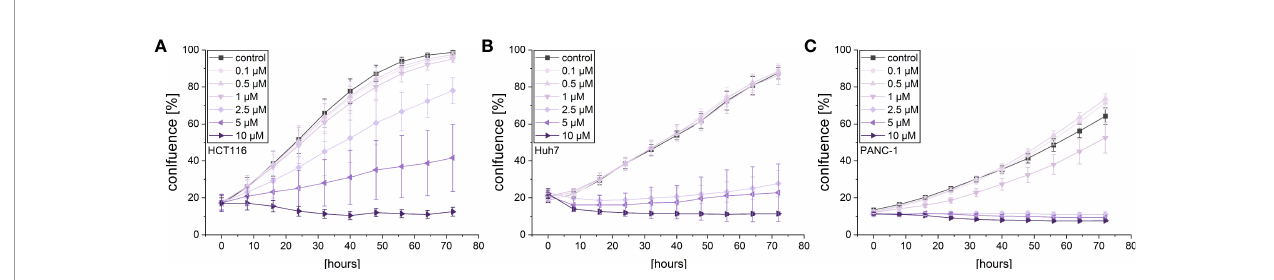
FIGURE 2 | Live-cell microscopy-based analysis of the anti-proliferative effect of violacein. Cell con fl uency of (A) HCT116, (B) Huh7, and (C) PANC-1 cells was monitored in an IncuCyte ® S3 system during violacein or DMSO solvent control treatment over 72